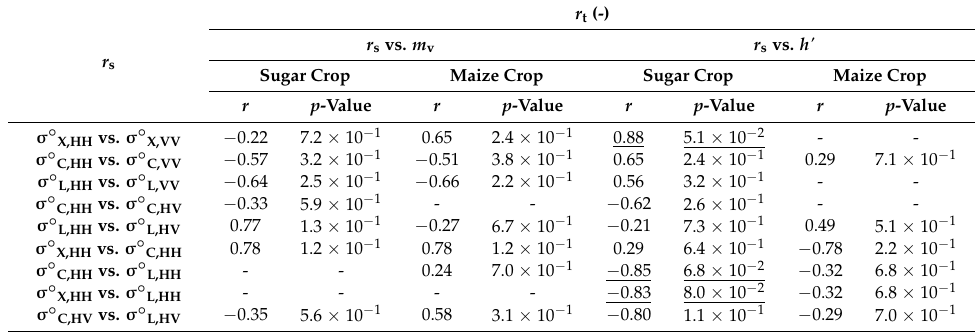
Table 7. r t , over bare soils occurring during the study period; q uasi -significant correlations (i.e., characterized by 0.05 < p -value < 0.1) are outlined; very weak correlations ( r < 0.19) are not reported.